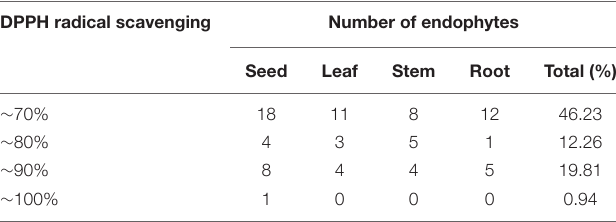
TABLE 3 | Number of endophytes with different DPPH radical-scavenging